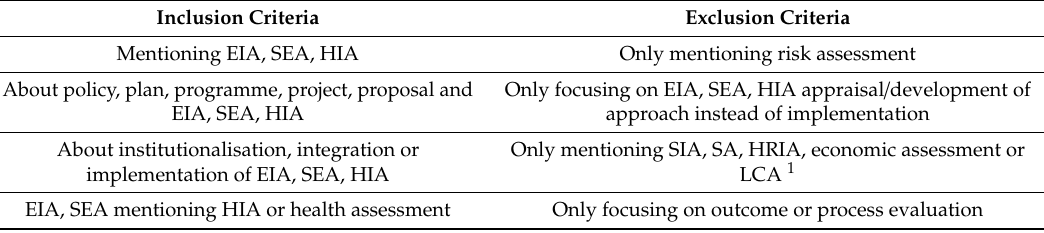
Table 1. Inclusion and exclusion criteria for scientific literature